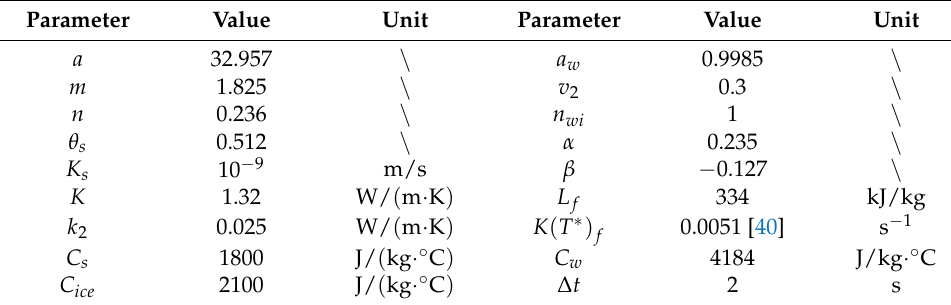
Table 3. Parameters required for numerical simulation.